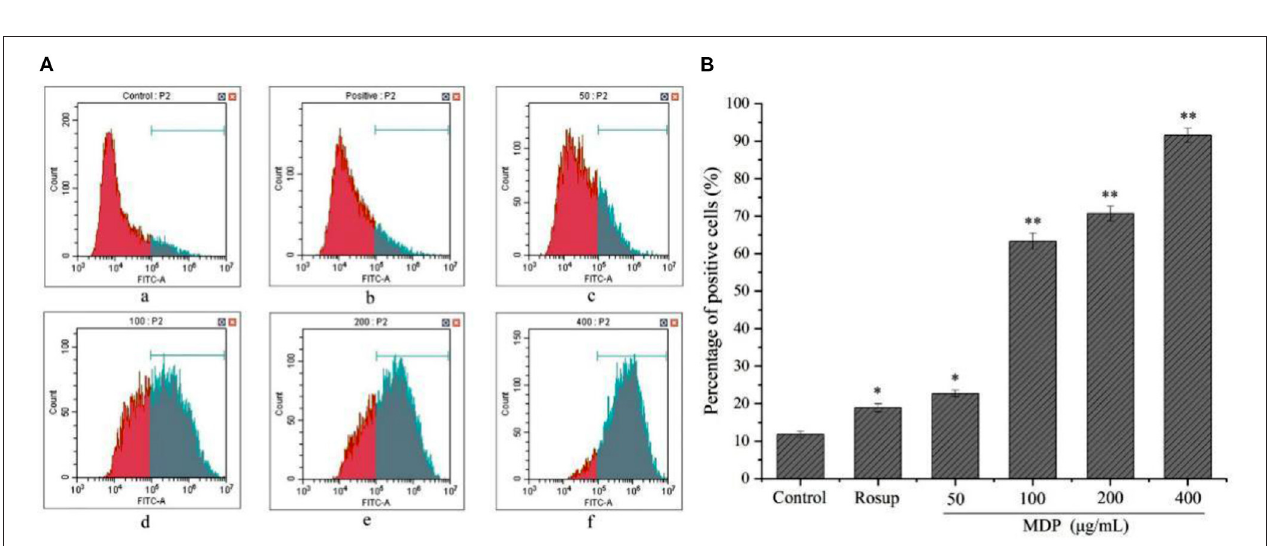
FIGURE 7 | Effect of MDP on the production of ROS in RAW264.7 cells. (A) The production of ROS was examined by flow cytometry (a) Control group; (b) 50 µ g/mL Rosup; (c) 50 µ g/mL MDP; (d) 100 µ g/mL MDP; (e) 200 µ g/mL MDP; (f) 400 µ g/mL MDP. (B) Quantitative analysis of the ROS production in RAW264.7 cells. The values are reported as the mean SD, n 3. * P < 0.05 or ** P < 0.01 vs. control ± =